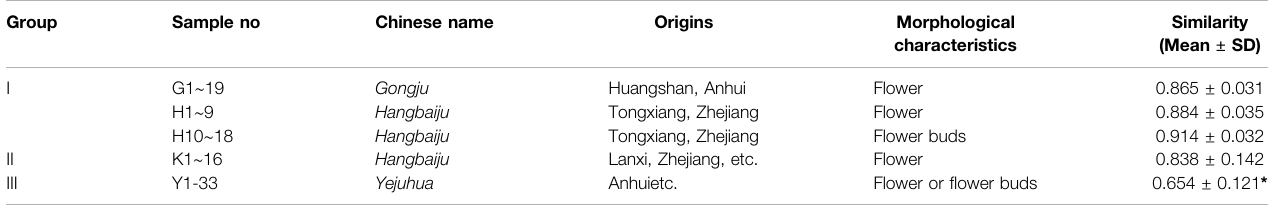
TABLE 1 | Sample information of C. morifolium fl ower and C. indicum fl ower samples.